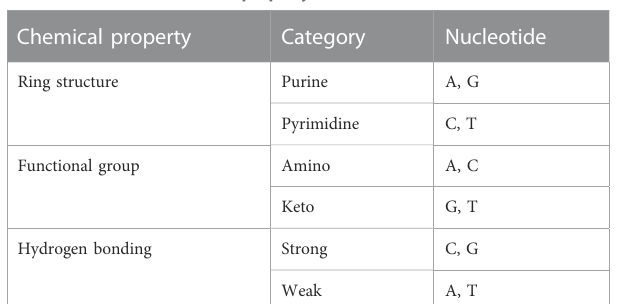
TABLE 2 Nucleotide chemical property.